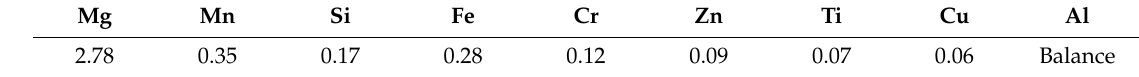
Table 1. Chemical composition of AA5754 H111 alloy (%).